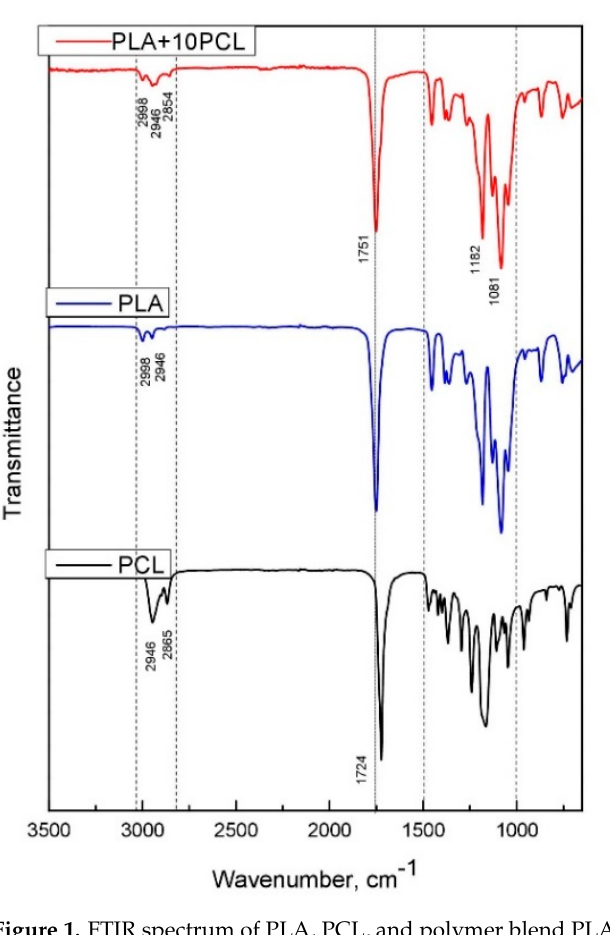
Figure 1. FTIR spectrum of PLA, PCL, and polymer blend PLA+10%PCL.